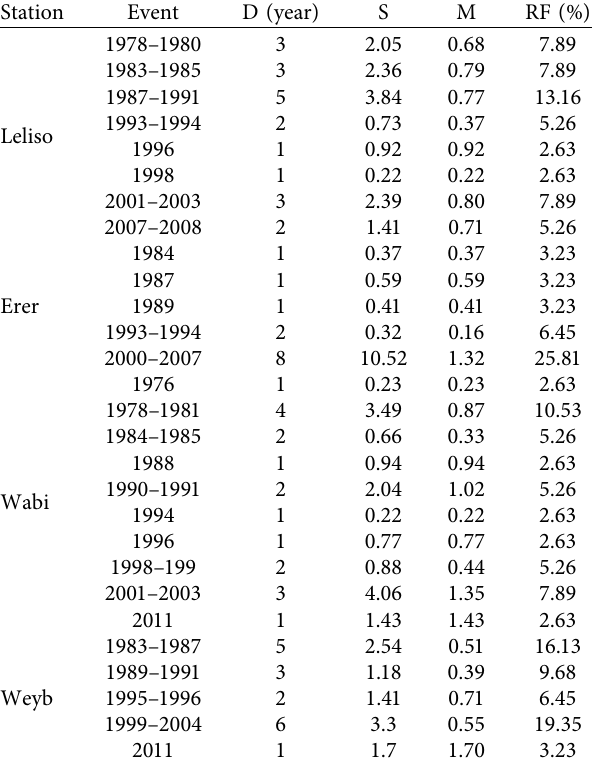
Table 12: Hydrological drought characterization in Ethiopian major river basins, Rift Valley River basin. Station Event